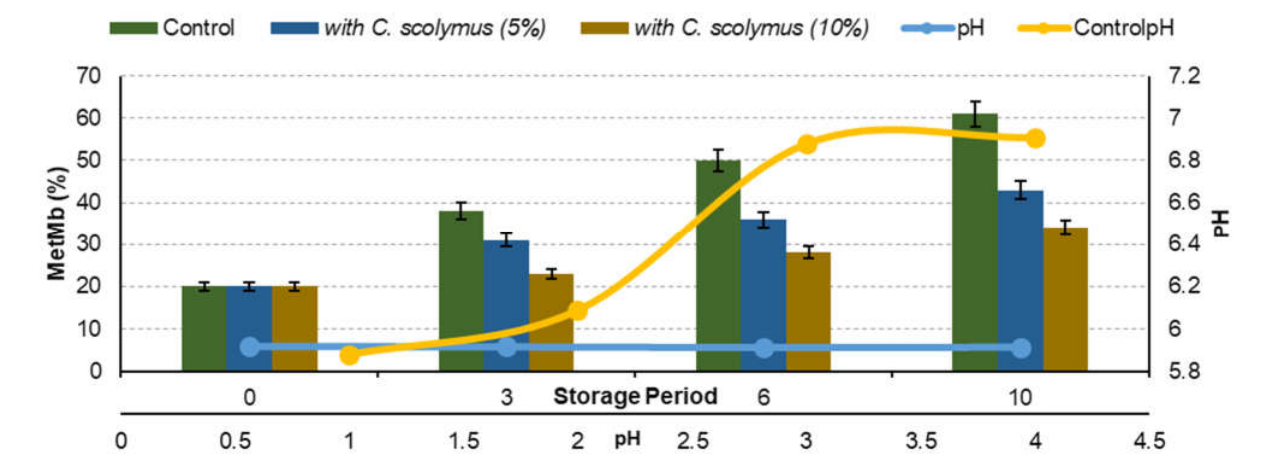
Figure 6. MetMb (%) and pH changes in meat samples marinated with C. scolymus powder.